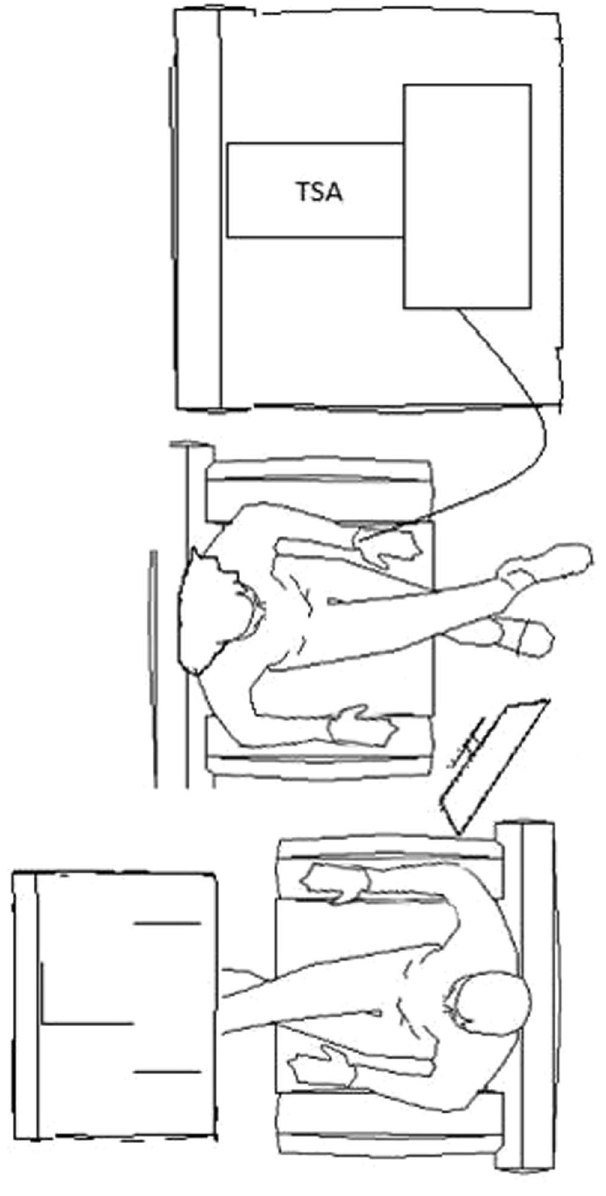
Figure 1. No touch-pain condition.